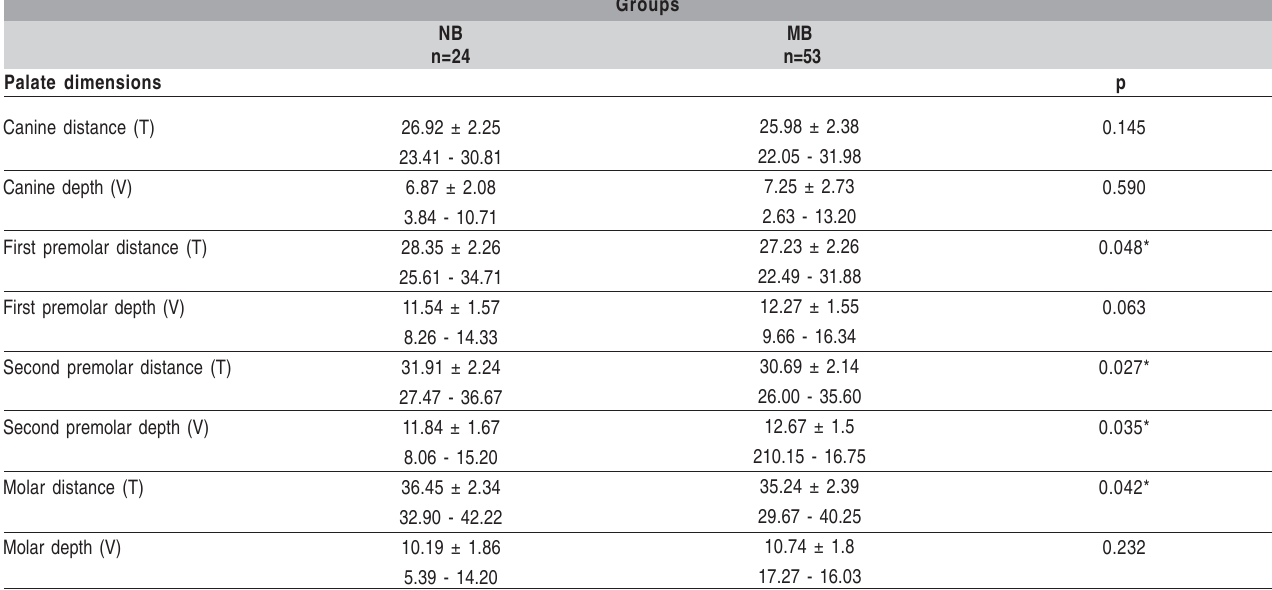
Table 1: Comparative results of mean and standard-deviation ( ± S), minimal and maximal values (X (T) and vertical (V) palate dimensions in the mouth and nasal breathers, regardless the presence the nonnutritive sucking